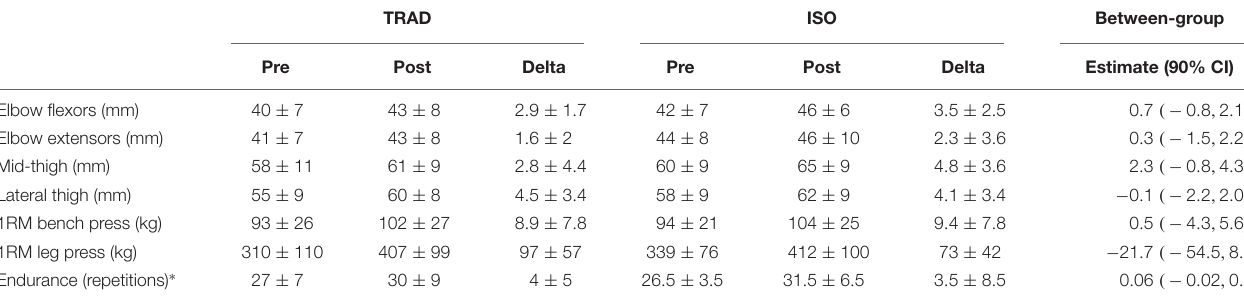
TABLE 2 | Experimental outcomes. TRAD ISO Between-group Pre Post Delta